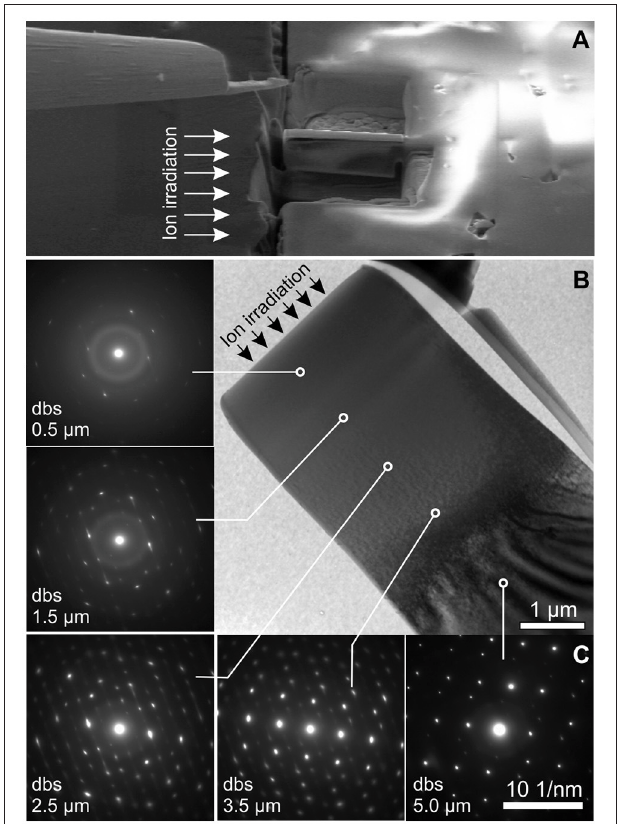
FIGURE 6 | (A) SEM image illustrating the focused-ion beam (FIB) preparation of a TEM-foil obtained from the cross-sectioned irradiated surface of YPO 4 ceramic sample d5 (the direction of the ion-irradiation indicated by arrows). (B) TEM bright-field image of the FIB-prepared foil with selected-area electron-diffraction (SAED) patterns from various depths below the irradiated surface (dbs). Diffuse scattering in SAED patterns decrease with depth, indicating a decreasing fraction of amorphous YPO 4 from the surface to a depth of ∼ 5 µ